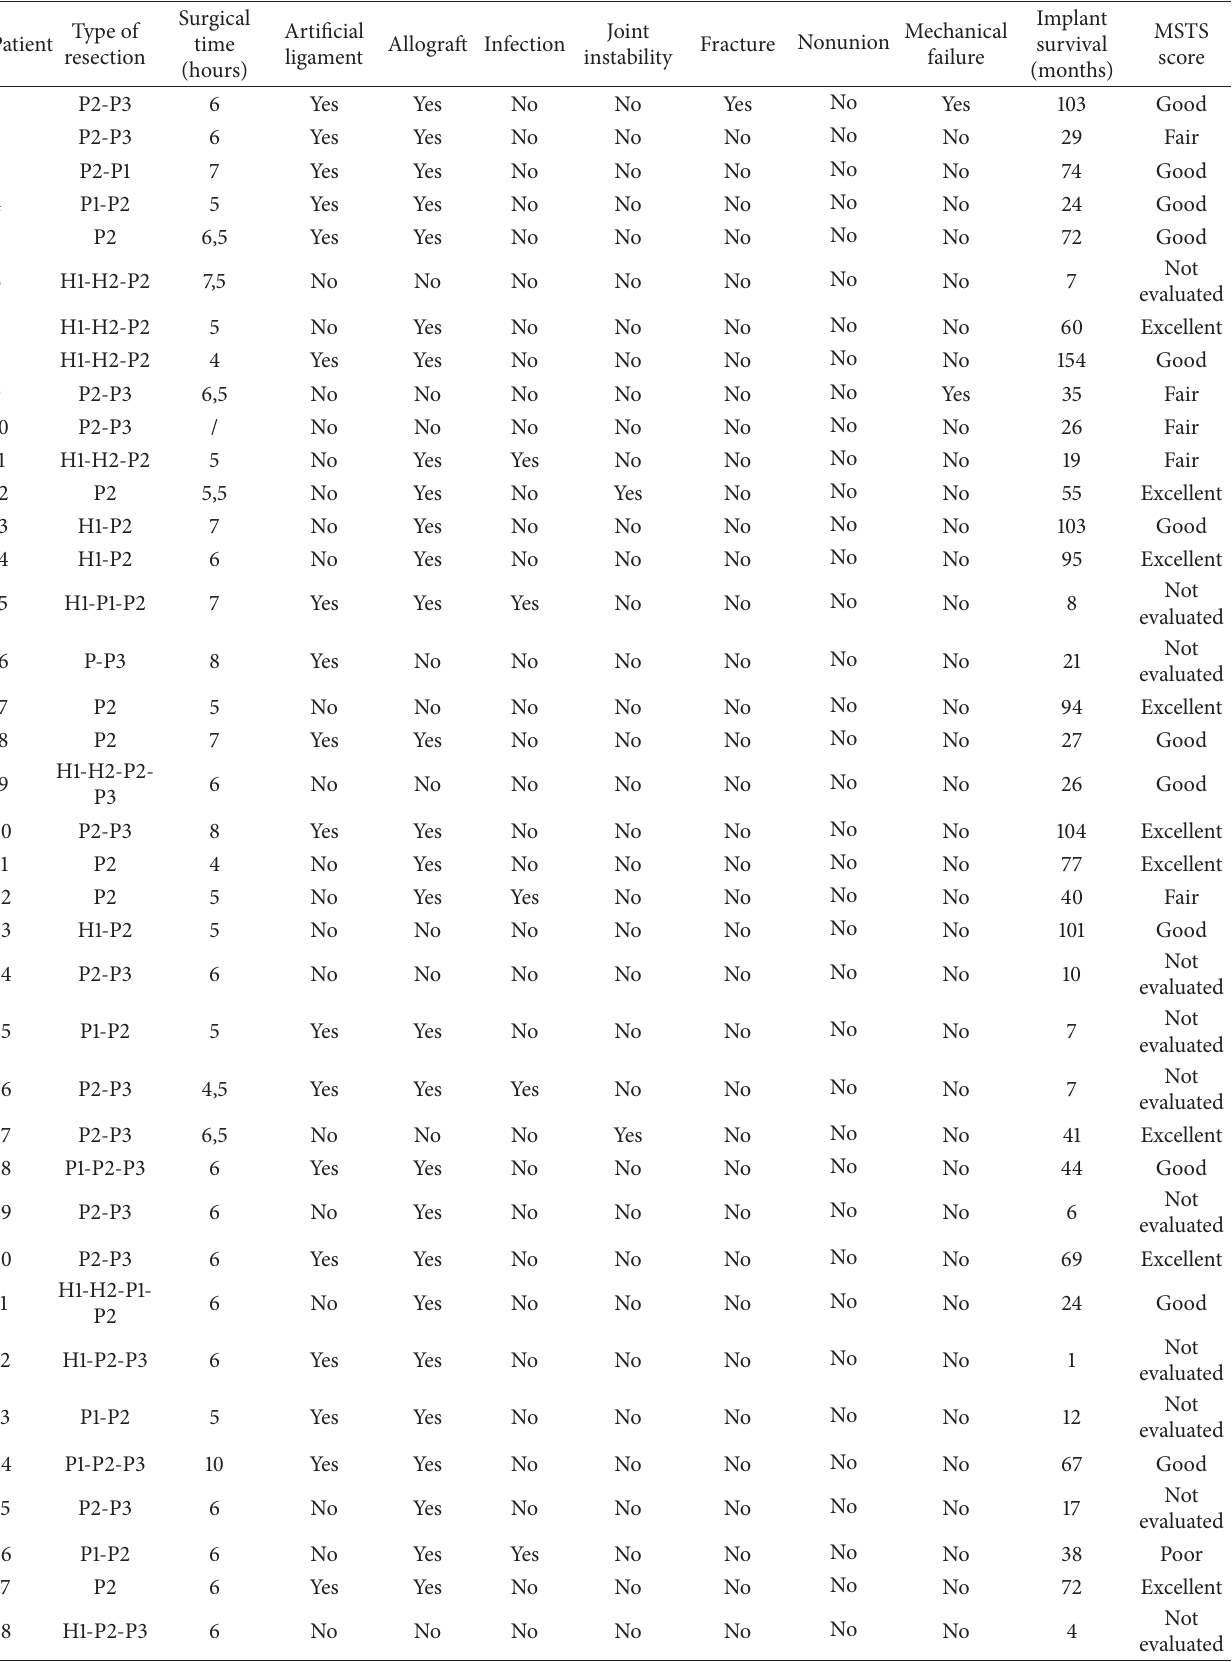
Table 2: Type of resection, operative time, complications, and functional outcome of the patients. Artificial ligament was used in 21 cases. Type of Patient